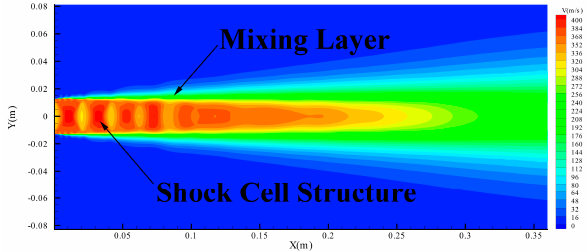
Figure 5. Shock cell structure and mixing layer in a supersonic jet.